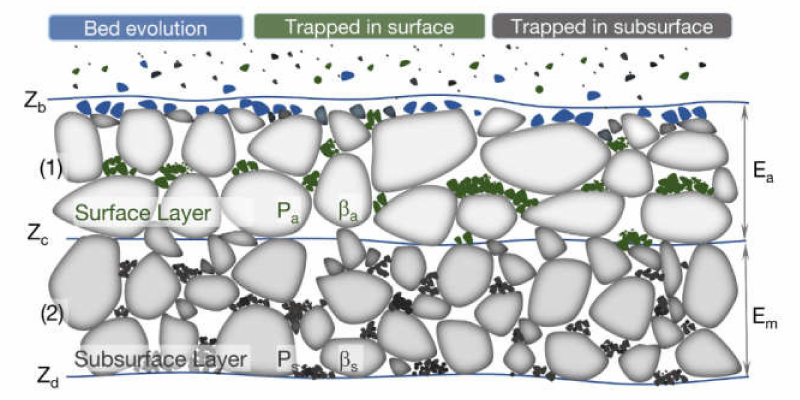
Figure 1. Conceptual two-layer model of fine sediment infiltration in grave